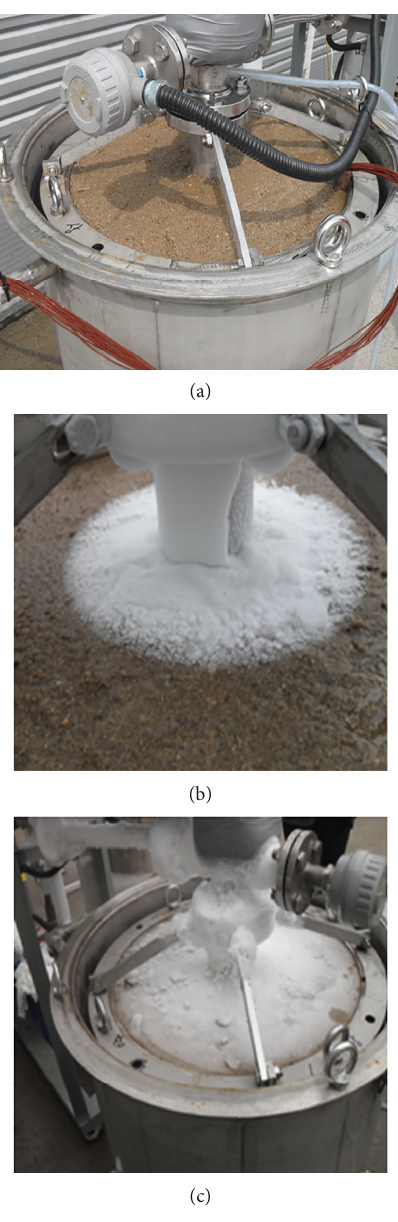
Figure 5: Progress of freezing on top of the sand Figure 7 shows the extraction of frozen soil sample and